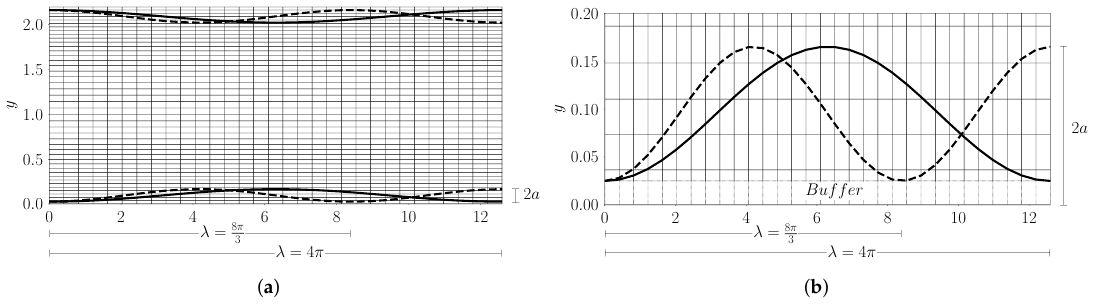
Figure 2. Schematic illustration of the Cartesian grid with the immersed boundaries of different shapes ( a ) and a close-up of the buffer region ( b ). The solid thick curve represents the wave for λ = 4 π and the dashed line for λ = 8 π . A similar setup is used for other surface shapes as well. 3